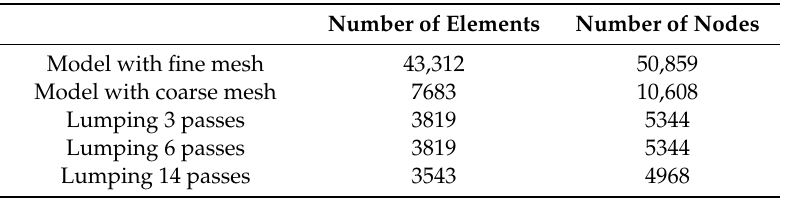
Figure 8. The first pass added in the simulation. The legend is expressed in °C. ( a ) No lumping for the model with coarse mesh. The height corresponds to the real thickness of one DED layer. ( b ) Lumping of three layers. The height corresponds to the thickness of three DED layers. ( c ) Lumping of six layers. ( d ) Lumping of 14 layers. Table 5. Number of elements for the simulation